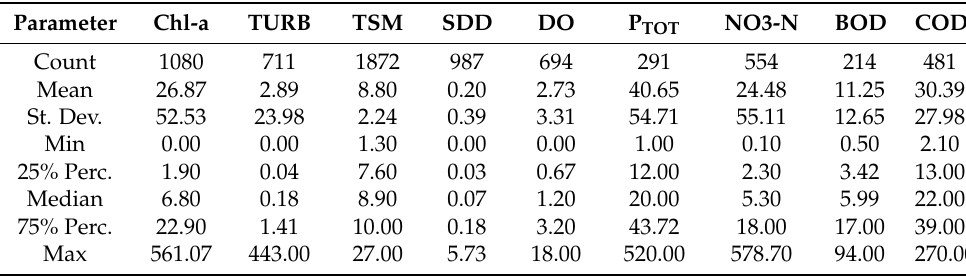
Table 5. Descriptive statistics of our study parameters. Abbreviations as follows: (St.Dev: Standard Deviation, Perc.: